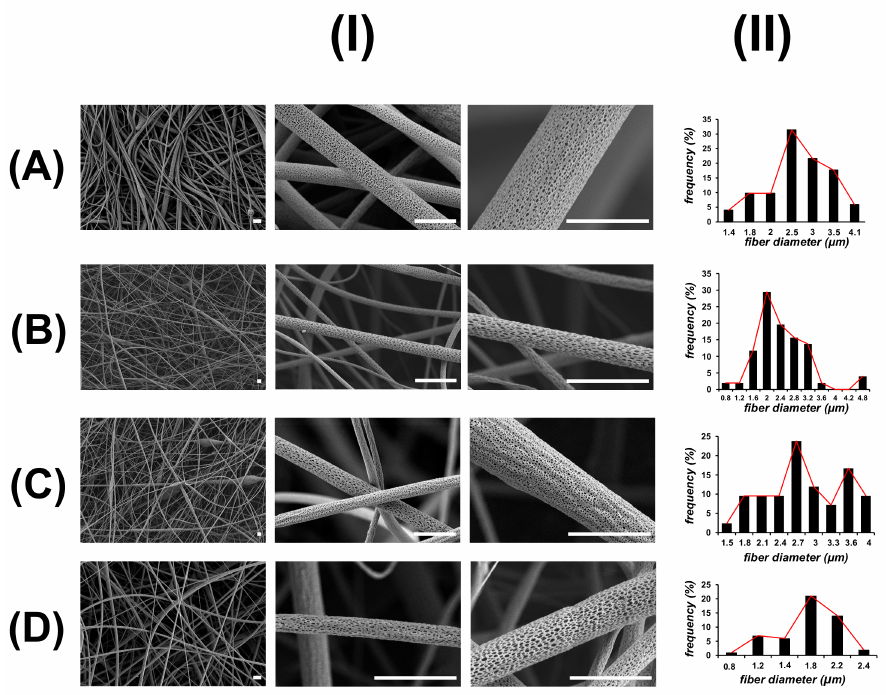
Figure 3. SEM images ( I ) and size distribution of fiber diameter ( II ) of PLA-based electrospun fibers: ( A ) PLA10, ( B ) PLA/PEG, ( C ) PLA/PEG/2.5HA, and ( D ) PLA/PEG/5.0HA. Scale bar is 5 µ m.